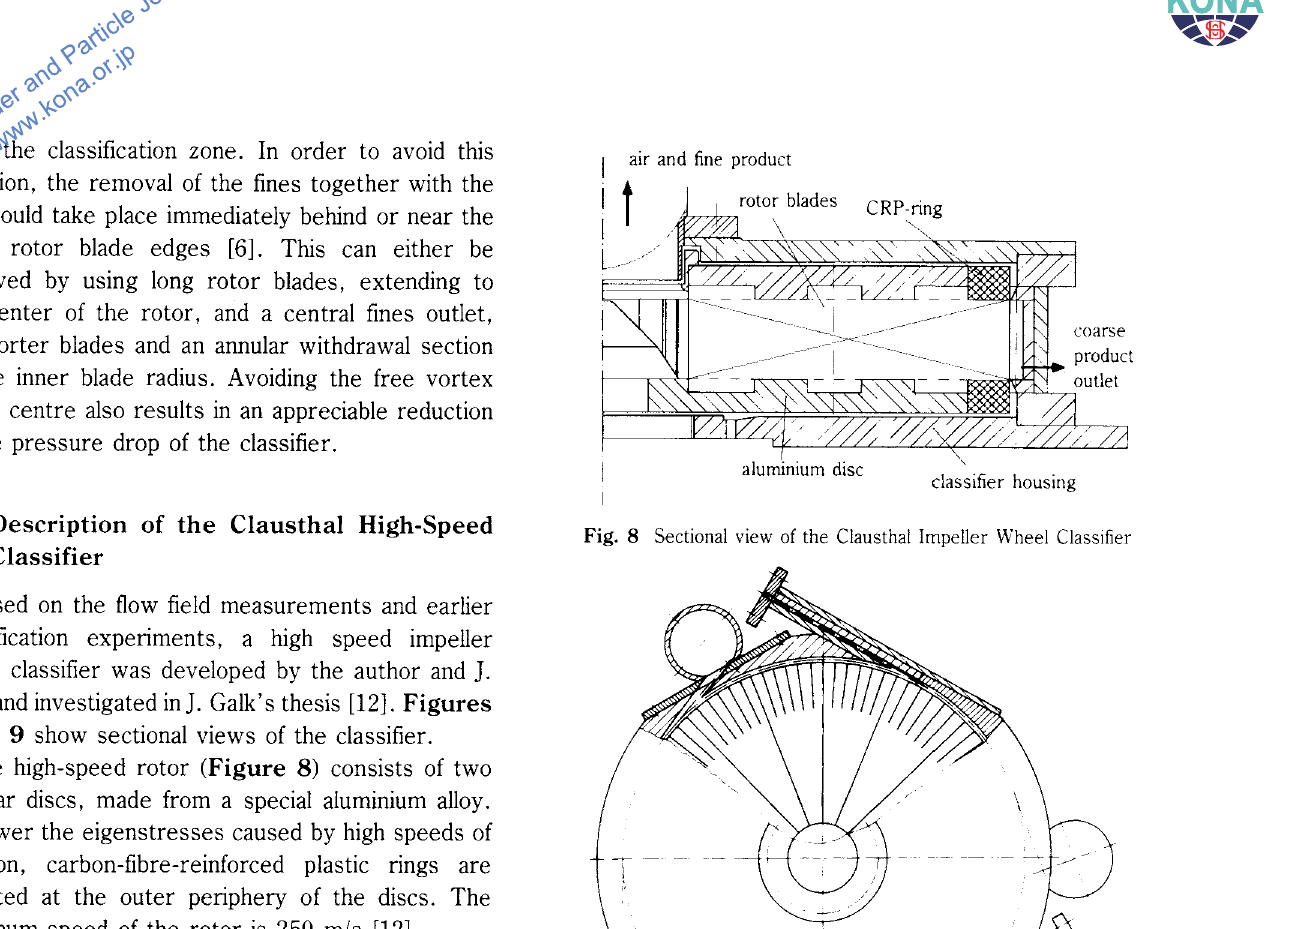
Fig. 8 Sectional view of the Clausthal Impeller Wheel Classifier